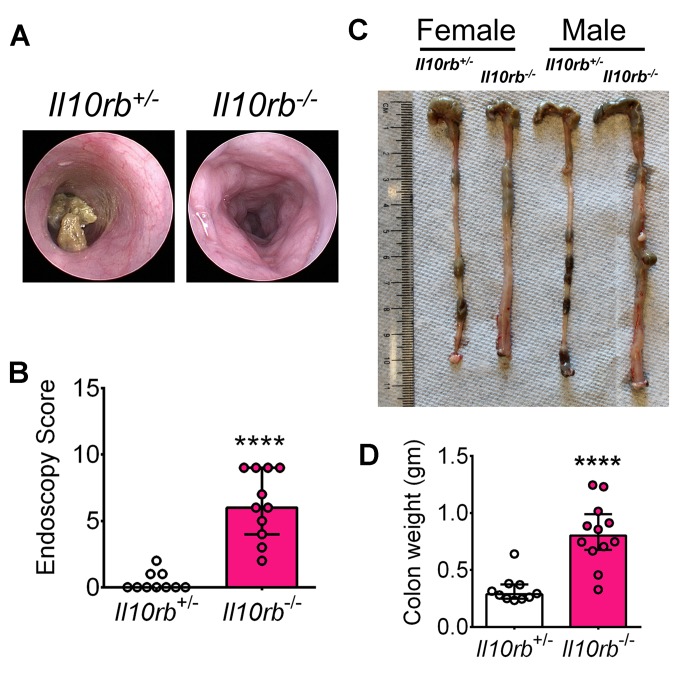
Severe colitis in 6 month old Il10rb-/- mice.(A) Representative endoscopic images, (B) Endoscopy score, n = 10–12; (C) Representative gross colon images, and (D) Colon tissue weights without fecal contents at 6 months (30 weeks). Each data point represents one animal. ****p<0.0001, Mann-Whitney U test. Data shows Median with IQR.